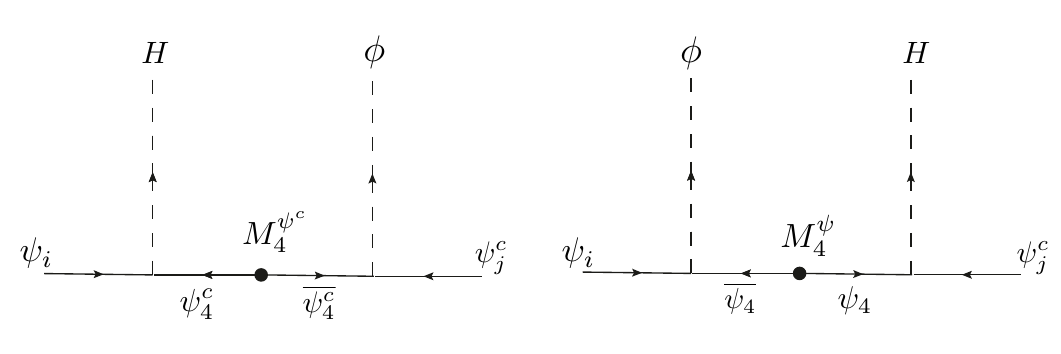
Figure 1 . Diagrams in the model which lead to the e(cid:11)ective Yukawa couplings in the mass insertion